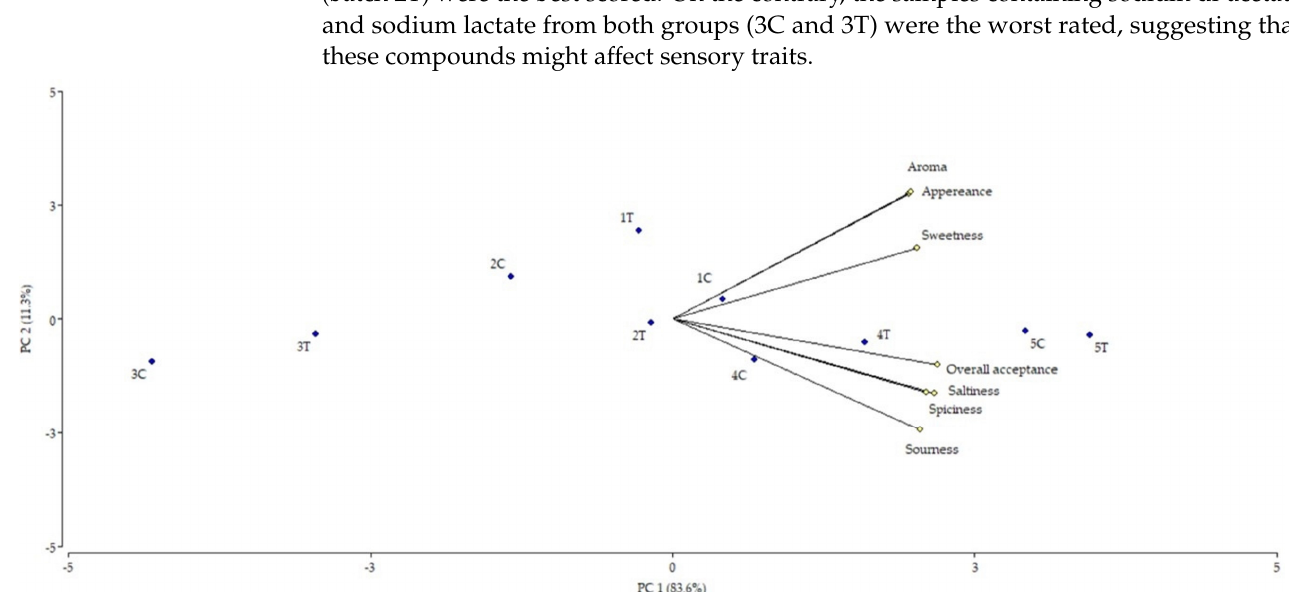
Figure 2. Principal component Analysis (PCA) of the sensory study conducted to the ten batches considering appearance, aroma, sweetness, spiciness, saltiness, sourness, and overall